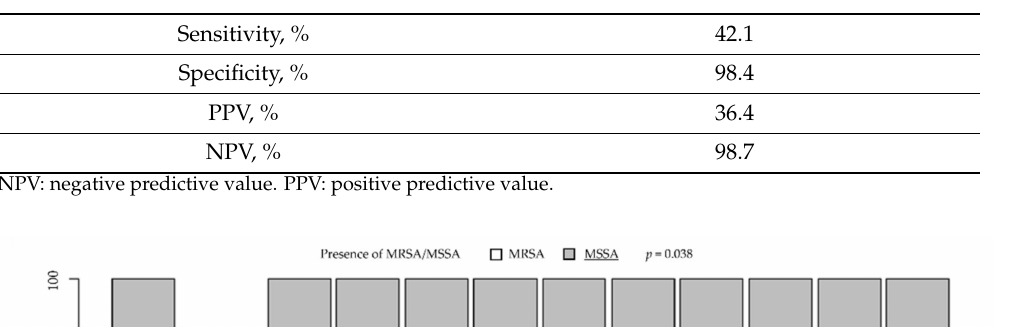
Table 3. Statistical analysis.